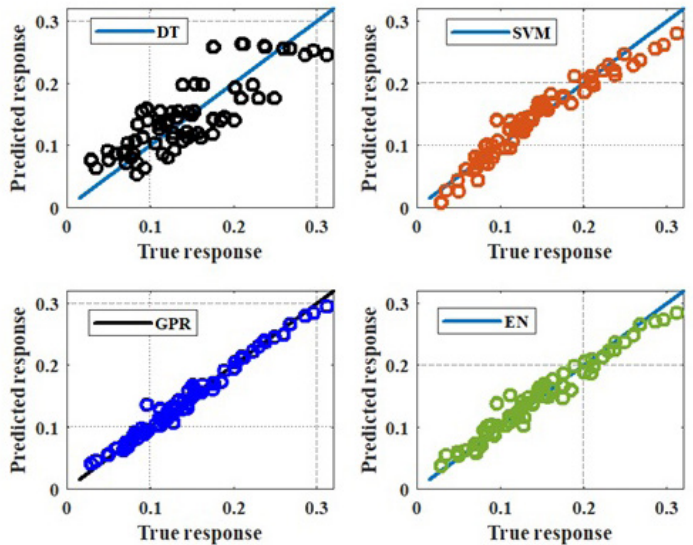
Figure 5. Predicted response against the true response of the different OMLR methods through the training period.